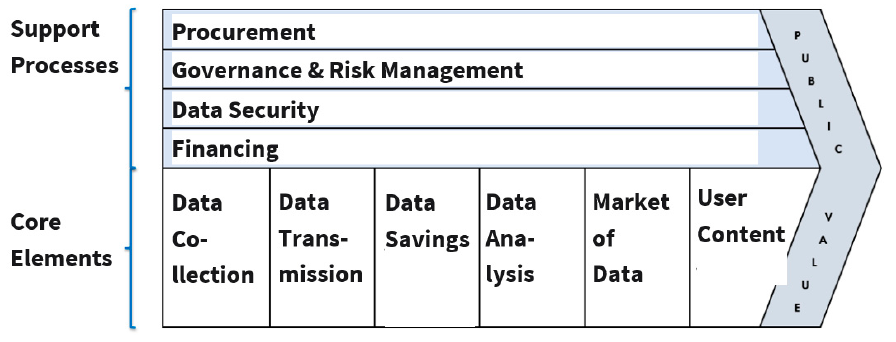
Figure 1. Public Value Chain.